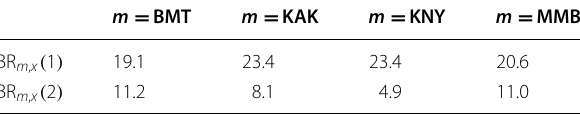
Table 2 BR m , x ( 1 ) and BR m , x ( 2 ) of BMT, KAK, KNY, and